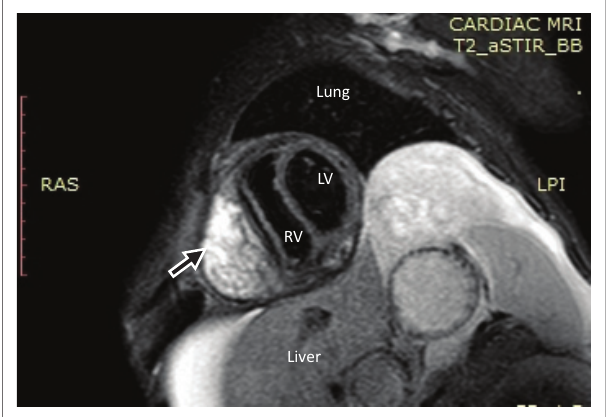
FIGURE 2: The lesion (black arrow) remains hyperintense on the T2 weighted short axis series.